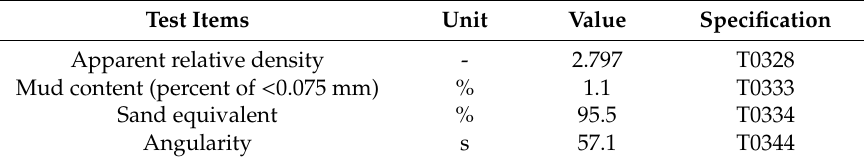
Table 3. Physical Properties of Fine Aggregate.